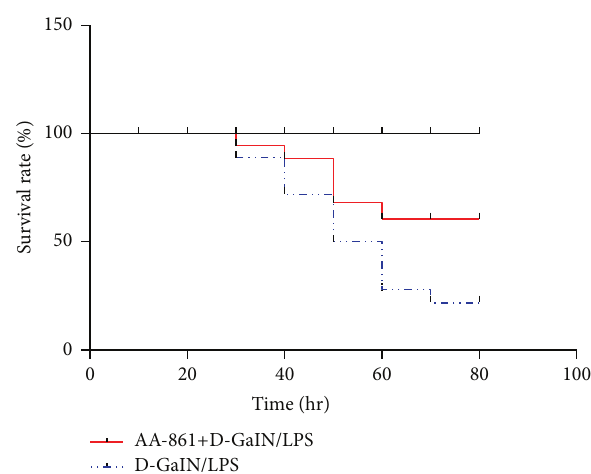
Figure 3: Blocking the 5-LO synthetic pathway improved the survival rate in D-GalN/LPS-treated animals. The survival rate in acute hepatic group and AA-861 treatment